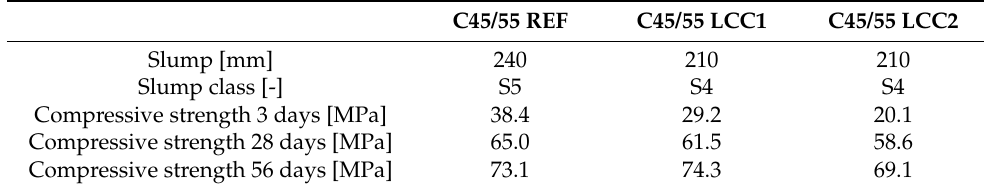
Table 2. Concrete